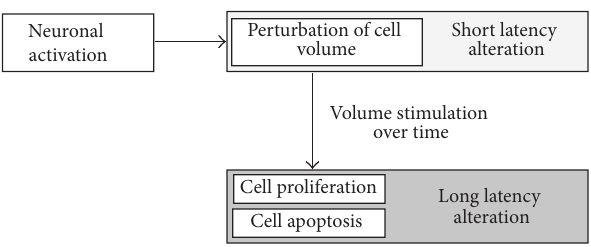
Figure 3: Possible physiological connection between short latency and long-latency voxel-based morphometry (VBM) alterations based on water shifts. Neuronal activation following flicker- ing checkerboard stimulation goes along with immediate water depended changes of cell volume that could be detected as short latency gray matter changes in VBM paradigms. Persistent water alterations induce long-term downstream effects leading to cell proliferation and apoptosis that might reflect the long-latency gray matter changes in VBM paradigms (for review